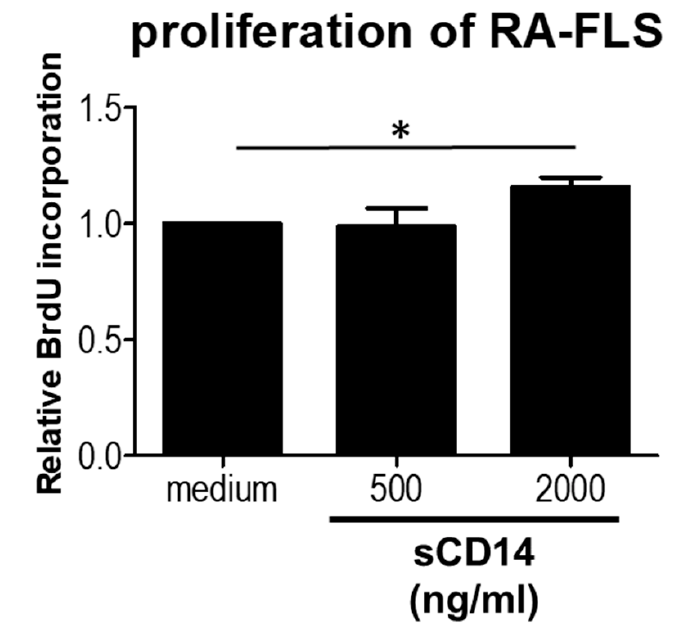
Figure 2. Soluble CD14 induces the expression of proinflammatory cytokines / chemokines by RA-FLS. RA-FLS were cultured with or without sCD14 (500 ng / mL) for 3 and 6 h. Thereafter, relative expression levels of IL-8, ICAM-1, IL-1 β , TNF- α , GM-CSF, CCL5, CXCL10, MMP-3, RANKL, and COX-2 mRNA were measured by real-time PCR and were normalized to GAPDH mRNA. The mRNA expression of RANKL was exhibited at 6 h, while the mRNA expressions of the others were exhibited at 3 h. Representative data are shown for the two incubation periods. Data are shown as means ± SEM in five RA-FLS. Statistical significance was analyzed by unpaired t -test (* p < 0.05, ** p < 0.01).